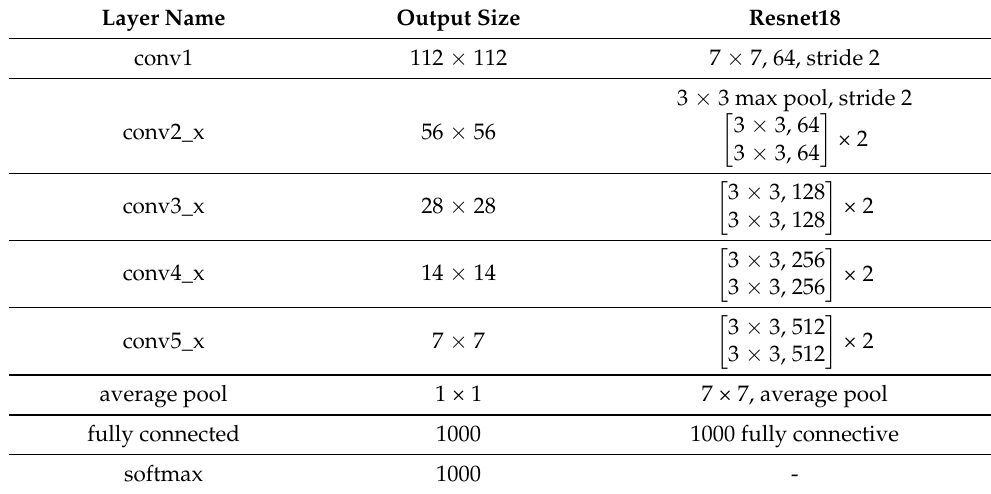
Table 1. Resnet18’s